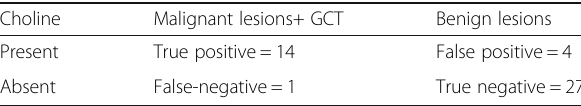
Table 3 Significance of choline peak in differentiating malignant lesions and GCT from benign lesions ( p -value<